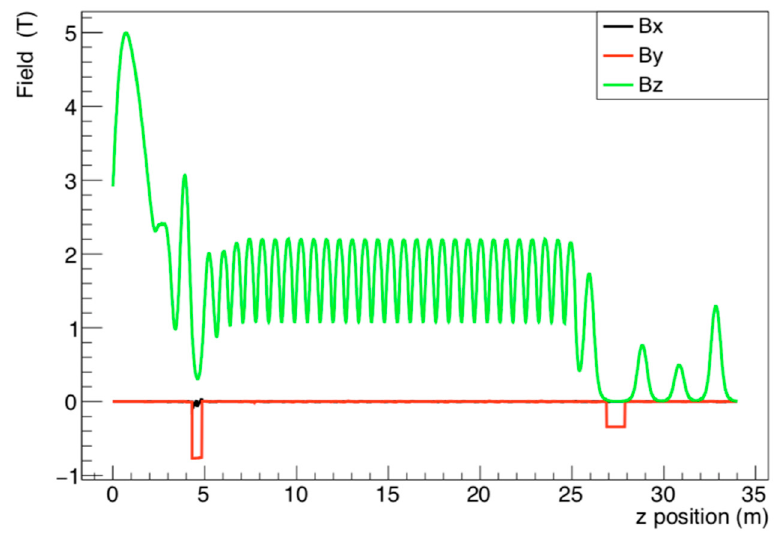
Figure 4. One magnetic field pattern along the trunk beamline for decay muons. Z = 0 corresponds to the entrance of the capture solenoid, and the target center is at the peak field of 5 T. The rectangular shape field drops in the red curve are bending magnets.